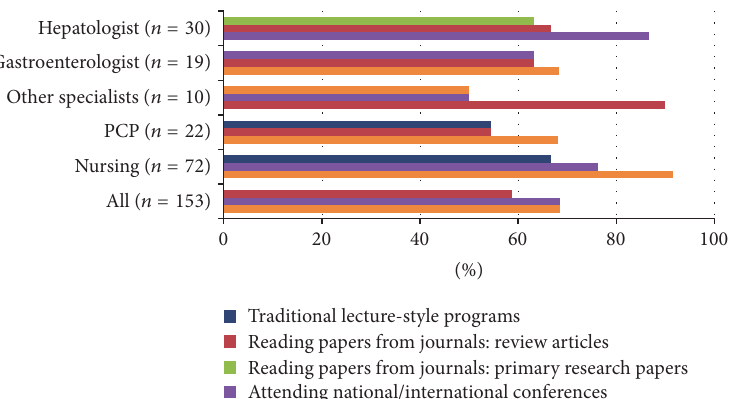
Figure 5: Preferred format of learning hepatitis C by